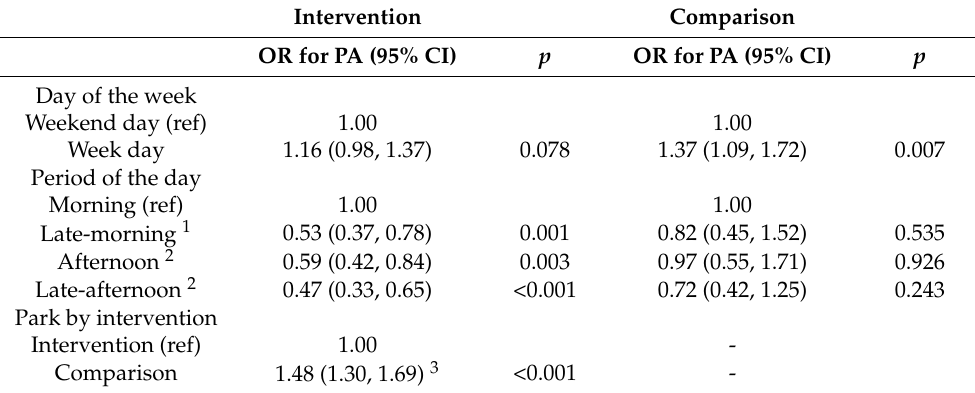
Table 4. Cont. Intervention Comparison OR for PA (95% CI)